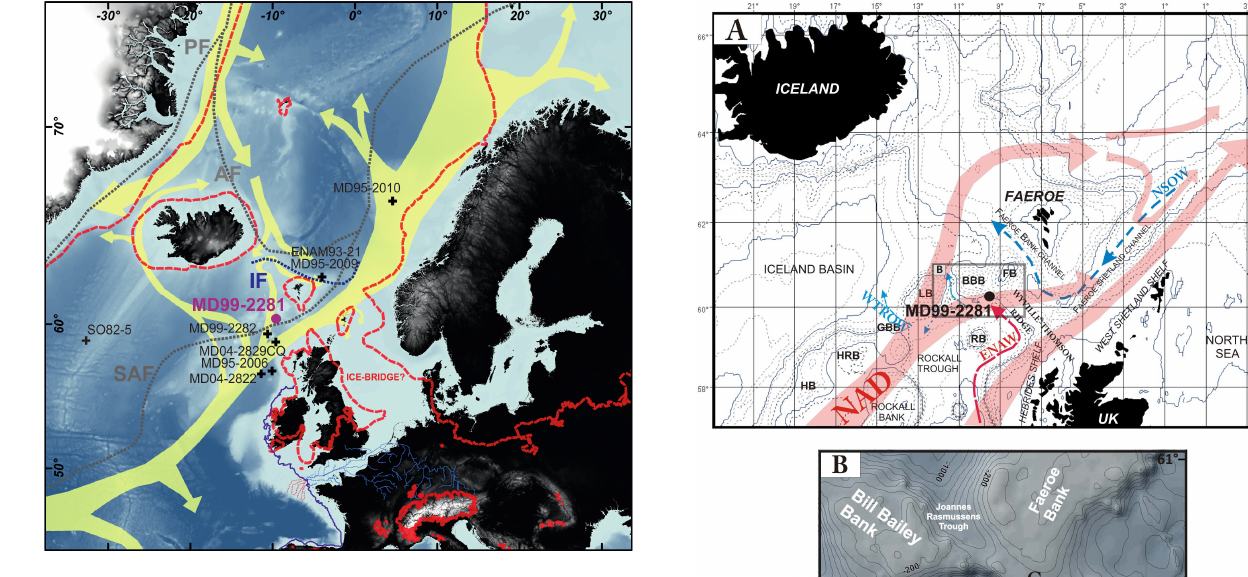
Fig. 1. Location of the studied core (MD99-2281: this work) and other cores discussed in the paper (MD95-2009; MD95-2010 – Ey- naud et al., 2002; ENAM93-21 – Rasmussen and Thomsen, 2004; core SO82-5 – Van Kreveld et al., 2000; MD04-2822; MD95- 2006 – Knutz et al., 2001; Hibbert et al., 2010; MD04-2829CQ – Hall et al., 2011). The yellow arrows depict the pathway of the main modern surface currents (Fogelqvist et al., 2003). Dotted grey lines locate major modern hydrographic fronts: PF=Polar Front, AF=Arctic Front, SAF: Sub-Arctic Front (Dickson et al., 1988). The IF=Iceland Faeroe Front is indicated by the dark blue dotted line (Rasmussen et al., 2002b). The palaeogeography of the adja- cent European continent during the Last Glacial Maximum with the hydrographic system/paleovalleys of the Manche River (Lericolais et al., 2003) and the paleo-coastline (bold blue line) at 21kaBP (Bourillet et al., 2003) are also depicted. The full glacial exten- sion of the North Hemispheric ice sheets (Grosswald and Hughes, 2002, and Ehlers and Gibbard, 2004) is schematized by the red dotted-line.